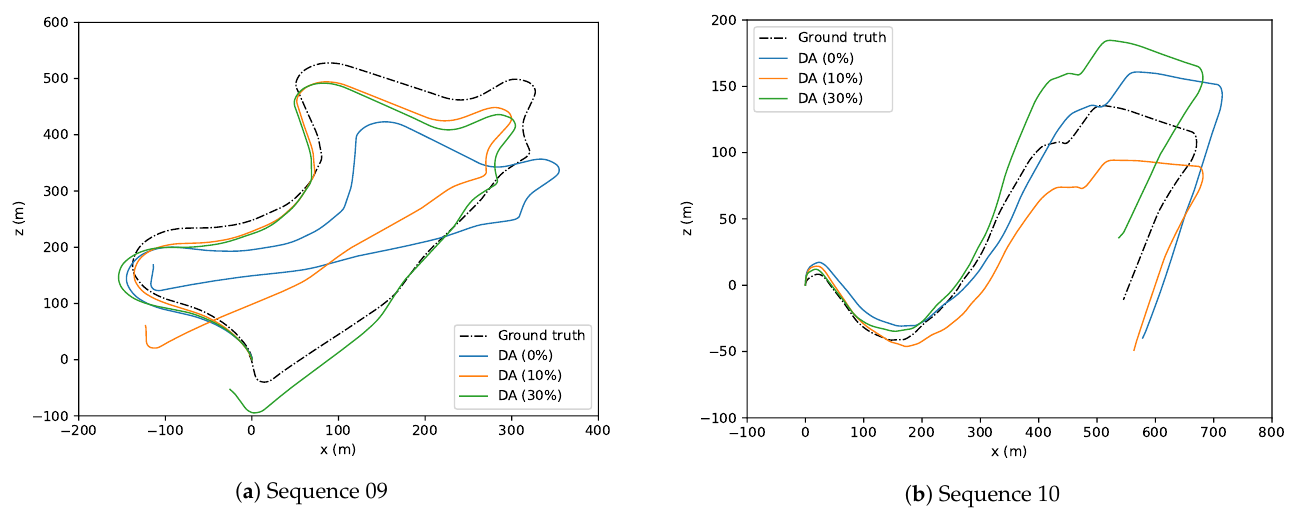
Figure 2. Trajectories of sequences 09 ( a ) and 10 ( b ) under different data augmentation (DA) quantities. X and Y -axis represent motion along the Z (forward) and X (left/right) axis of the vehicle in the vehicular